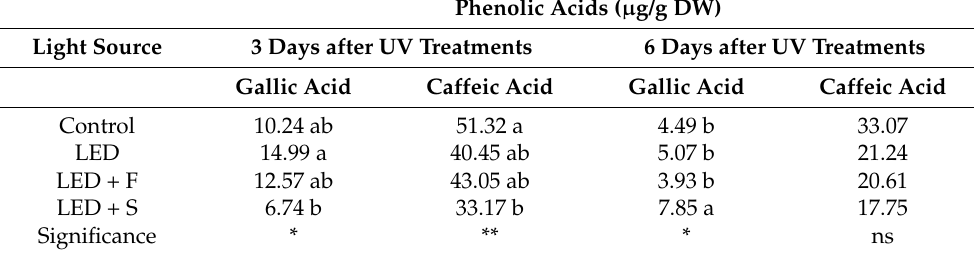
Table 4. Concentrations of individual phenolic compounds in lettuce variety ‘Two Star’ sub- jected to supplemental UV-A radiation. Treatments included LEDs, LEDs + focus lens (LED + F), LEDs + scatter lens LED + S), and control (Con). Measurements were made after 3 and 6 days of